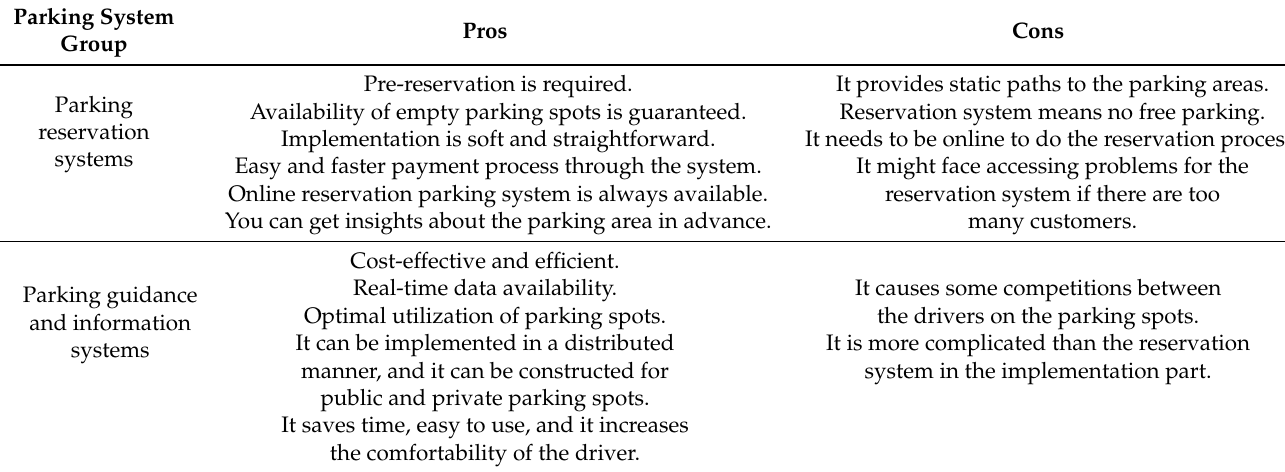
Table 1. Pros and cons of the reservation-based group and guidance-based